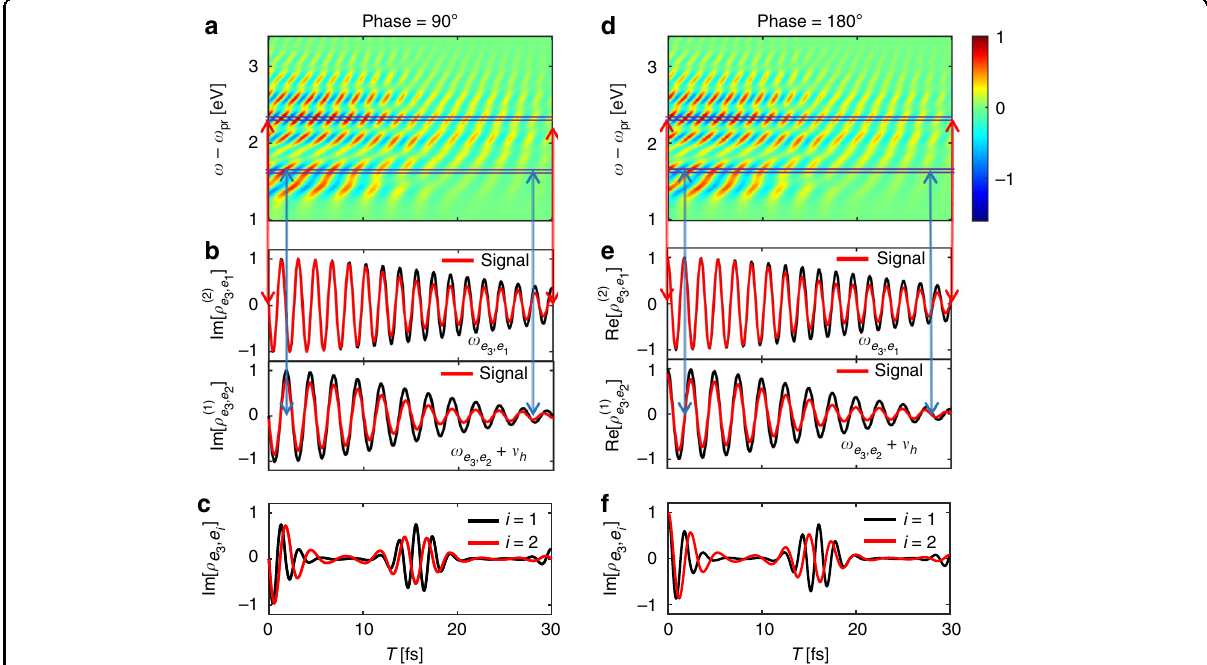
Fig. 3 Heterodyne-detected QFRS and dynamics of electronic coherence. (Left column) ( a ) Heterodyne-detected QFRS with the phase associated þ 2 v ¼ 2 : 32eV; Black line with Φ ð ω ; ω i Þ being − π /2 (a certain phase of local oscillator). (b, up) Red line is for the 1D slice of ( a ) at ω (cid:2) ω pr ¼ ω e h 3 ; e 1 (cid:4) . b (down) Same as b (up) but for ω (cid:2) ω ¼ is for the imaginary part of n = 2 harmonics of the electronic coherence ρ , i.e., Im ½ ρ ð 2 Þ e pr e 3 ; e 1 3 ; e 1 þ v ¼ 1 : 66eV and imaginary part of n = 1 harmonics of the electronic coherence ρ ω . c Imaginary part of time-evolving electronic e 3 ; e 2 h e 3 ; e 2 (cid:4) (black) and Im ½ ρ (cid:4) (red). (Right column) ( d ) Same as ( a ) but for the phase associated with Φ ð ω ; ω Þ being − π . e Same as coherence, i.e., Im ½ ρ i e 3 ; e 1 e 3 ; e 2 (cid:4) ; Re ½ ρ ð 1 Þ (cid:4) (black lines). f Same as ( c ) but for Re ½ ρ (cid:4) and Re ½ ρ (cid:4) . Parameters are the same ( b ) but for 1D slices of ( d ) (red lines) and Re ½ ρ ð 2 Þ e e 3 ; e 2 e 3 ; e 1 e 3 ; e 2 3 ; e 1